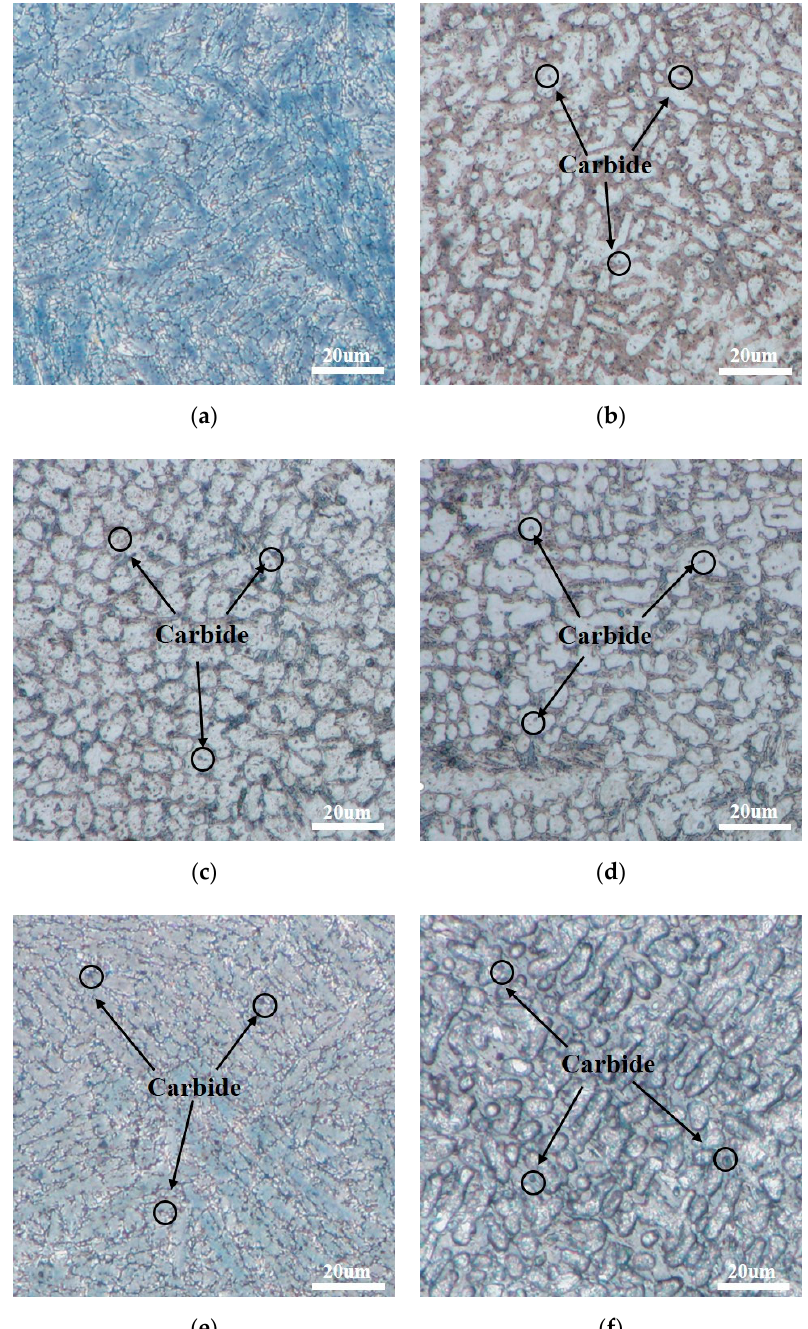
Figure 3. Microstructure of cladding coatings: ( a ) 0 HCT; ( b ) 3 HCT; ( c ) 6 HCT; ( d ) 9 HCT; ( e ) 12 HCT; ( f ) 24